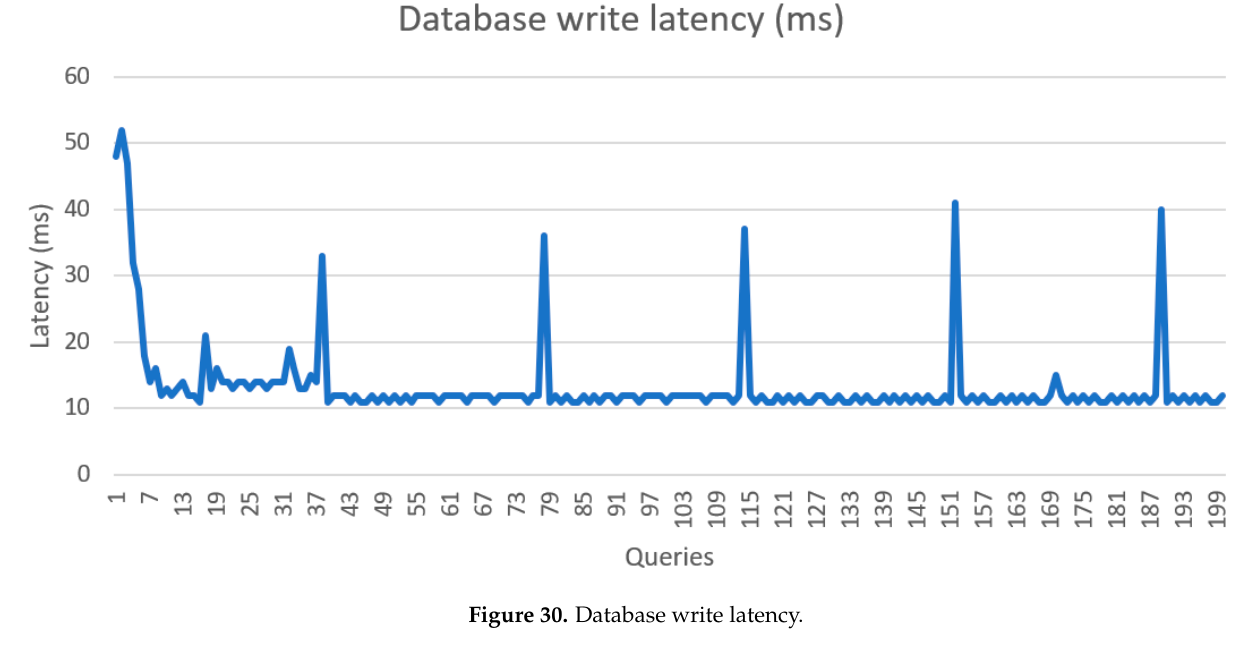
Figure 30. Database write latency.